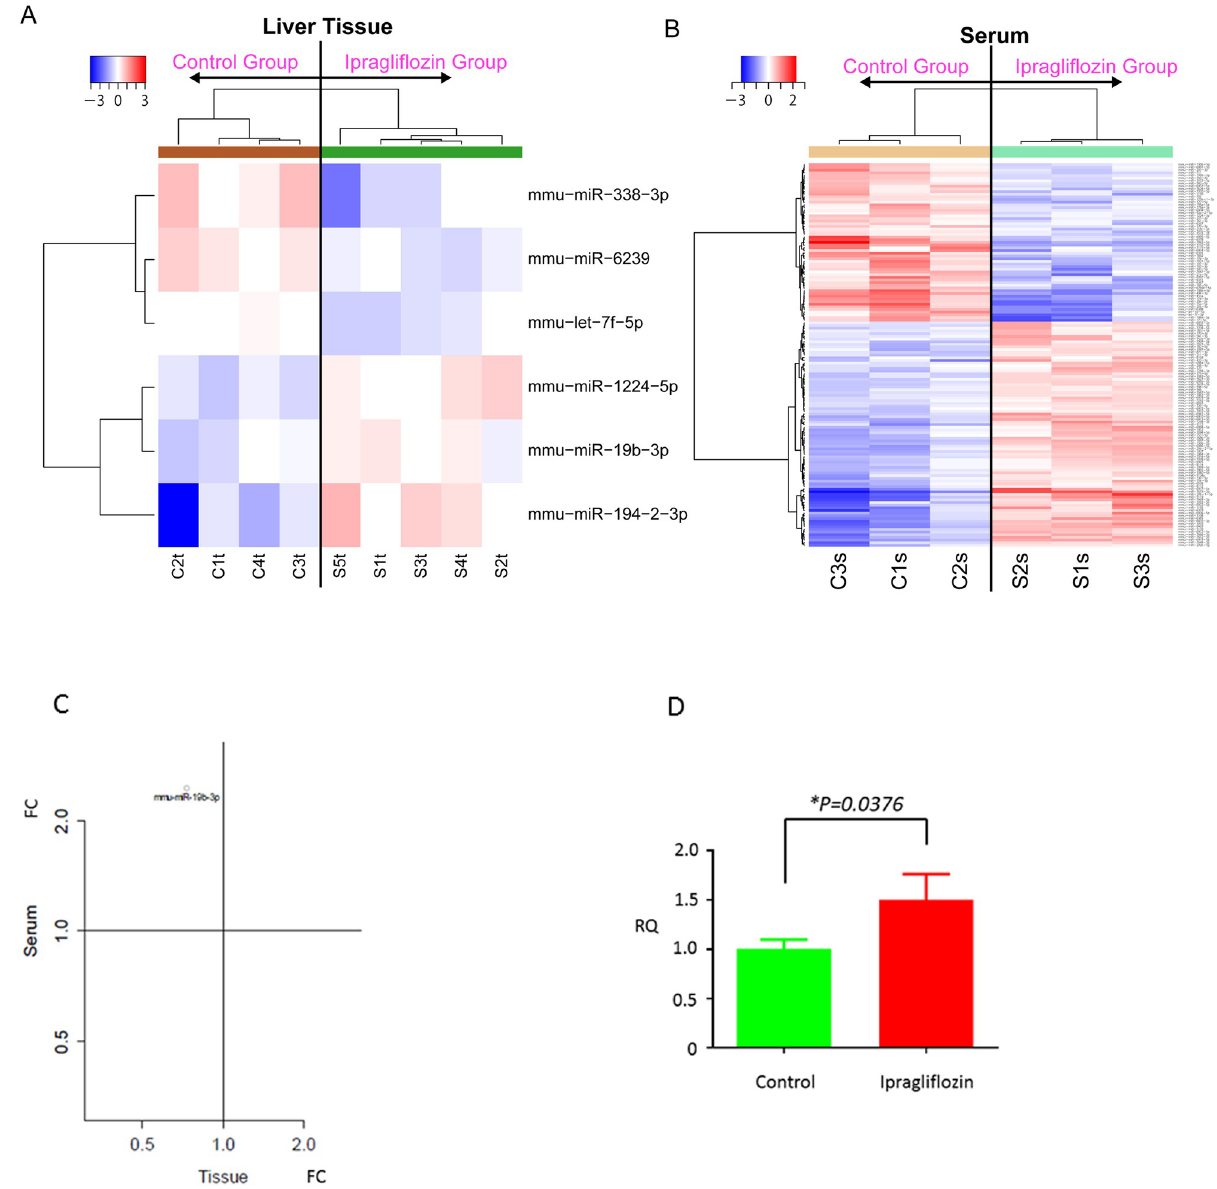
Fig 4. Hierarchical clustering of the liver tissue (A) and serum (B) from STAM mice between the control and ipragliflozin groups. Liver tissues and sera clustered according to the expression profiles of six differentially expressed miRNAs between groups. The analyzed samples are reported in columns and the miRNAs are presented in rows. The miRNA clustering tree is shown on the left, and the sample clustering tree appears at the top. The color scale shown at the top indicates the relative expression level of miRNAs, with red representing a high expression level and blue representing a low expression level. (C) Among 2555 miRNAs analyzed, miR-19b-3p was significantly upregulated in the serum and downregulated in the liver tissue of STAM mice after ipragliflozin administration. (D) RT-qPCR results showing that miR-19b-3p expression was significantly upregulated in the serum of STAM mice treated with ipragliflozin. Data are shown as the mean ± SD [ � P < 0.05 vs. control group (n = 8) or ipragliflozin group (n =